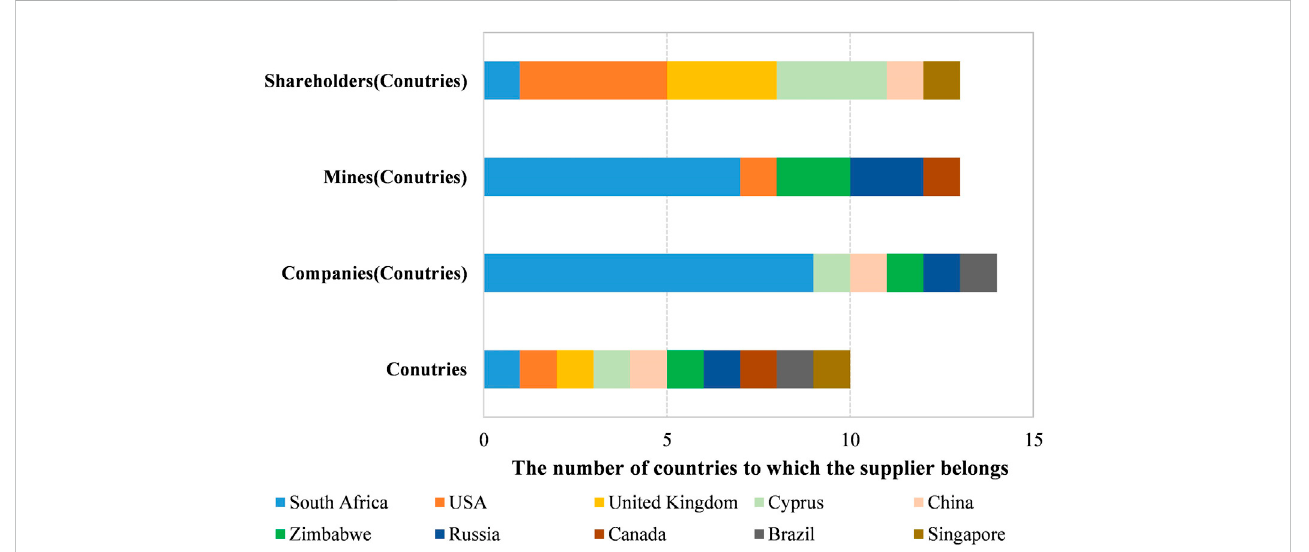
The countries of the top 10 suppliers of betweenness centrality in the global platinum supply